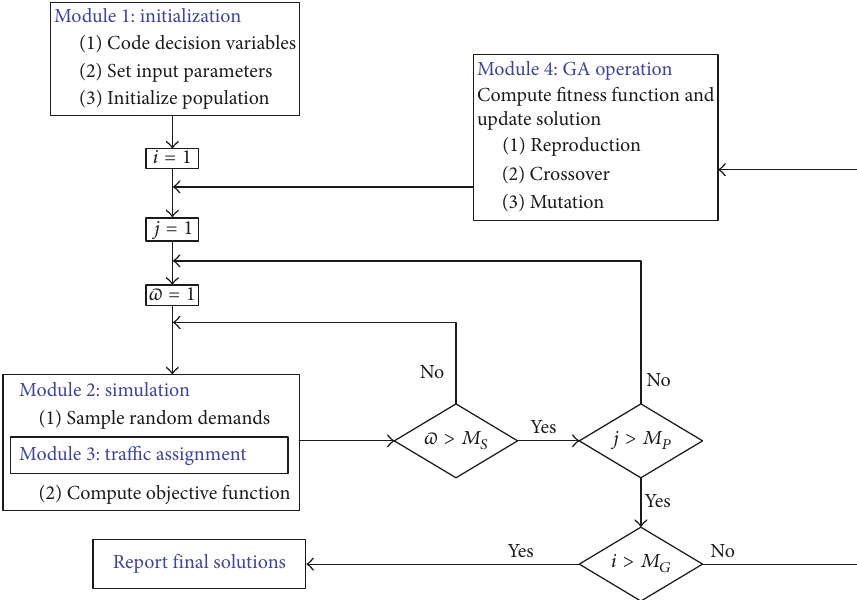
Figure 3: The simulation-based genetic algorithm for the EV-NDP